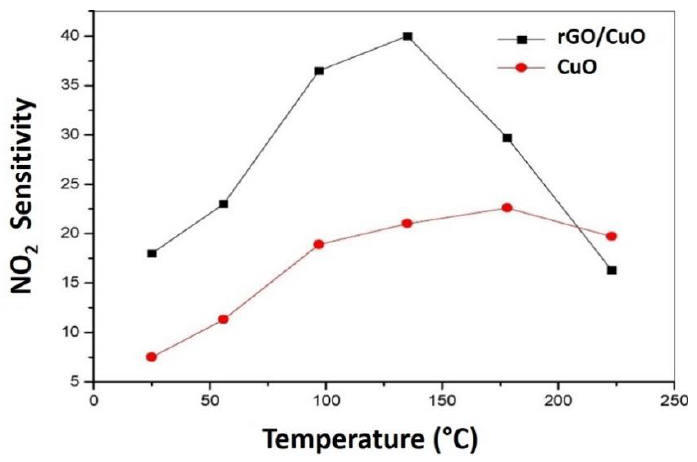
Figure 8. Comparison of the sensing performance of an rGO/CuO-based sensor with pristine CuO at 5 ppm NO 2 with temperatures from 30 °C to 225 °C. Reproduced from ref.